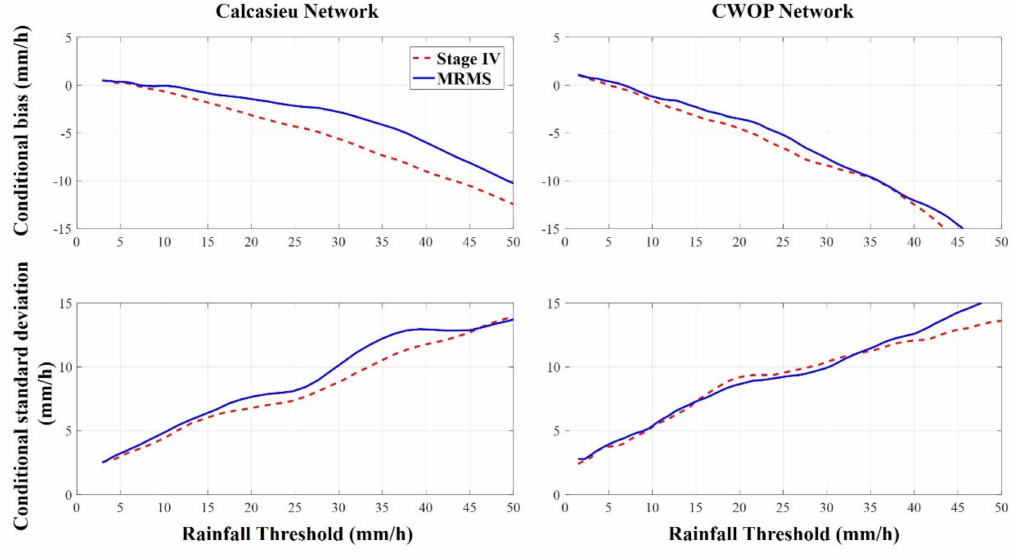
Figure 10. Conditional bias and standard deviation of the radar estimation error as a function of surface reference rain rate for Calcasieu and CWOP